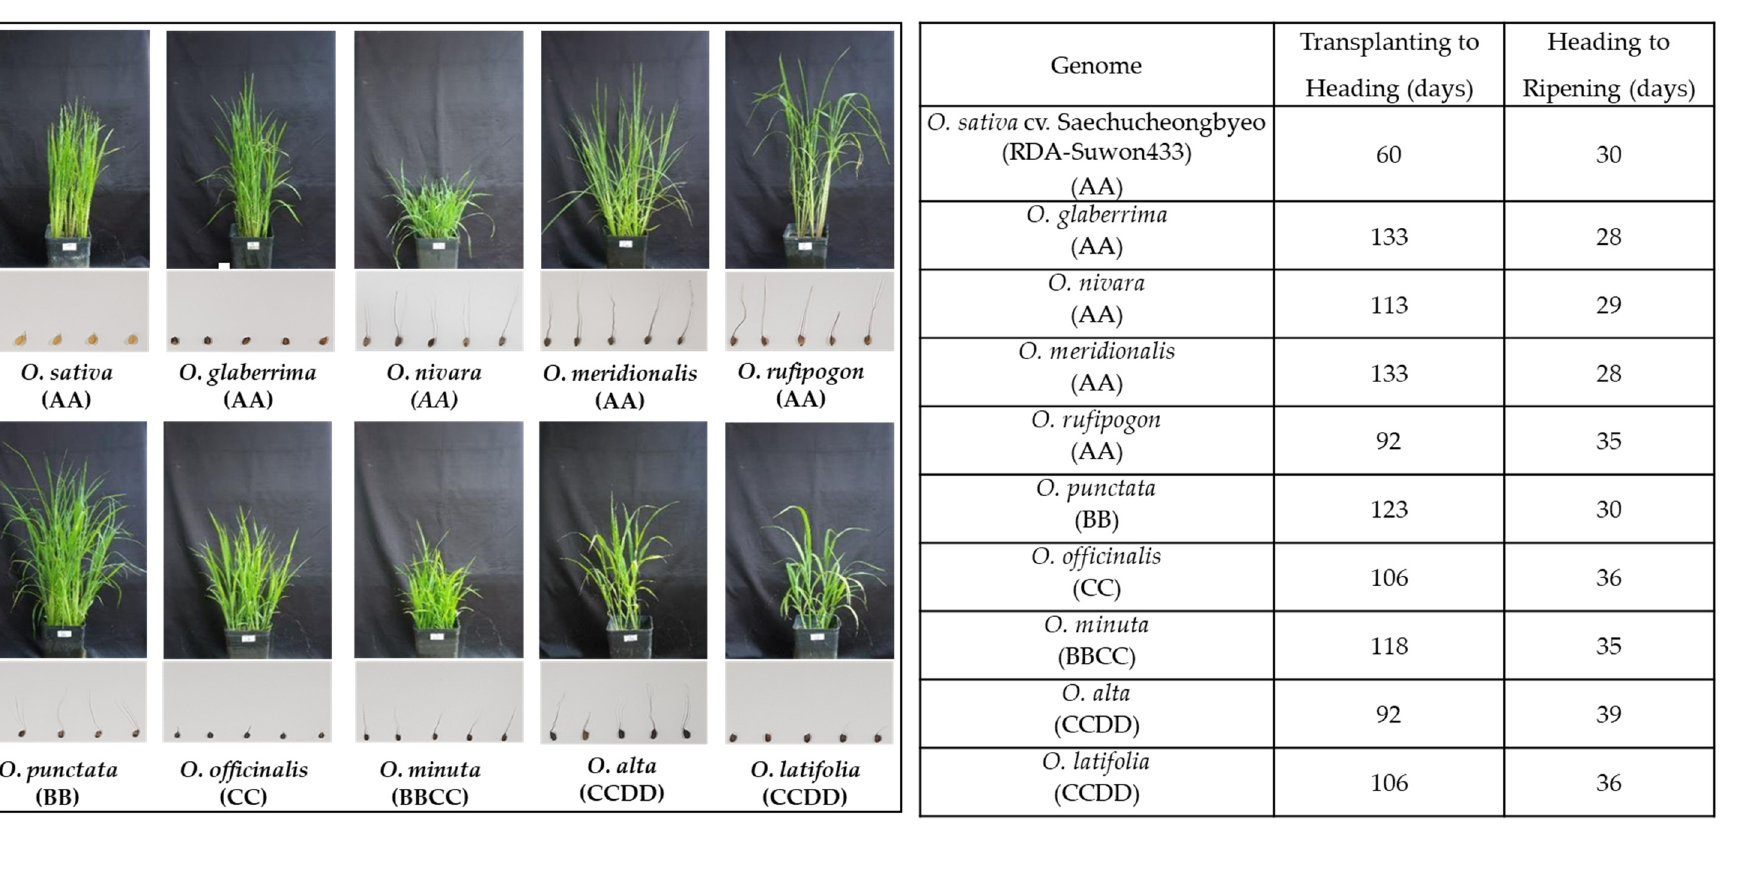
Figure 1. Phenotypic differences in shoot growth and seed between rice species ( A ) and the duration to heading or ripening ( B ). Rice seedlings were transplanted at the 3rd leaf stage and the images of rice shoots were obtained at the maximum tillering to panicle formation stage (60 days after transplanting, based on O. sativa cv. Saechucheongbyeo). The harvest of seeds differed from species due to different flowering times.